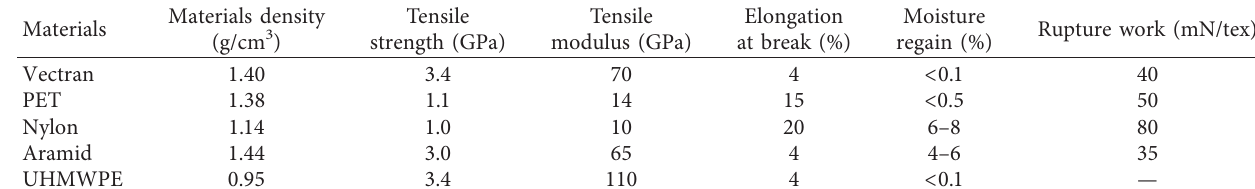
Table 2: Property of different industrial fibres adopted from